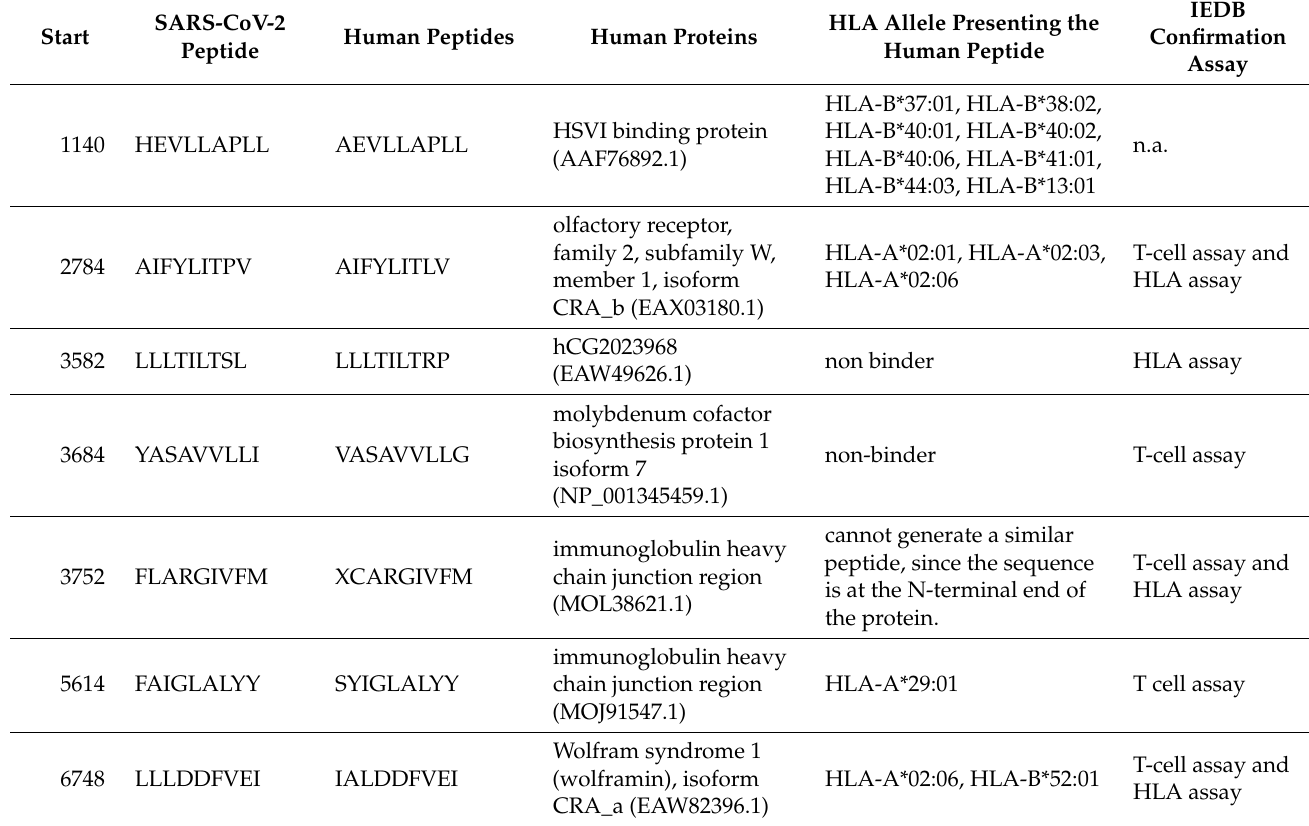
Table 7. SARS-CoV-2 peptides with sequence homologous with human peptides (underlined). The HLA alleles presenting the human peptides as revealed by NetCTLpan analysis are indicated. Some of these peptides were curated in IEDB and had been confirmed by T-cell assay, HLA assay, or